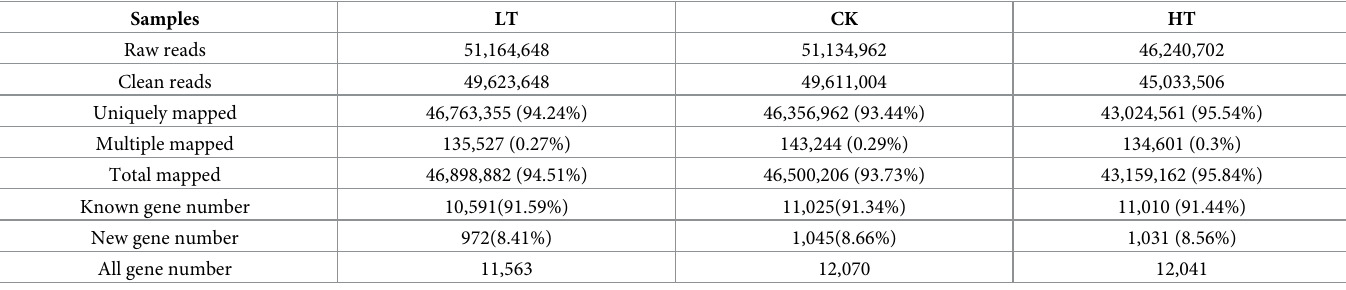
Table 1. Summary of the sequencing data and gene numbers of A . oryzae transcriptome under three temperature treatments.